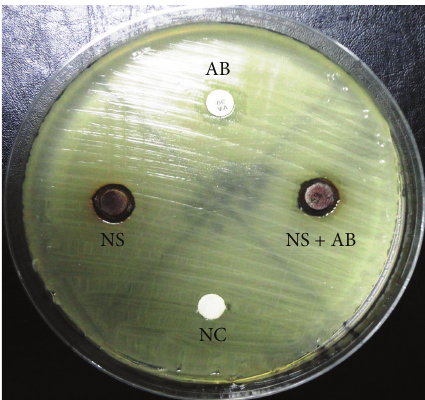
Figure 7: Synergistic effect between silver nanoparticles produced by SHE and vancomycin against MRSA isolates isolated from diabetic foot ulcer patients. NS: silver nanoparticles, AB: antibiotic of choice (vancomycin), NS + AB: silver nanoparticles and van- comycin, and NC: negative